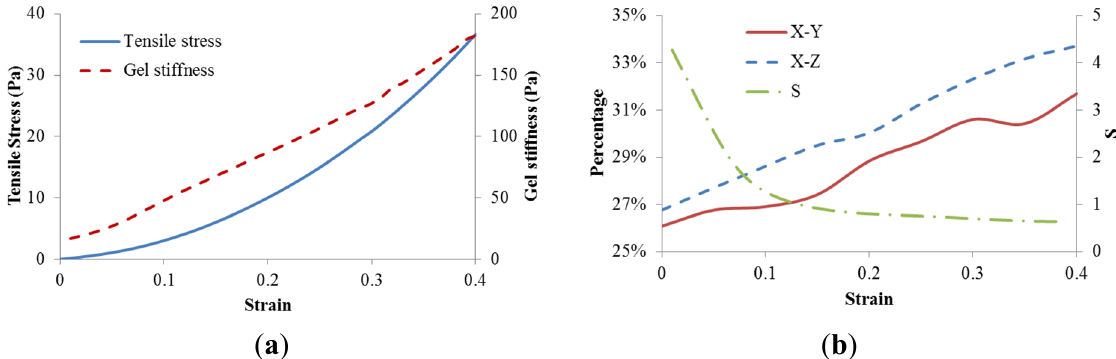
Figure 3. Dynamic results of baseline model. ( a ) Stress–strain relationship and gel stiffness along loading direction; ( b ) Percentage distribution of fibers in both x – y and x – z planes